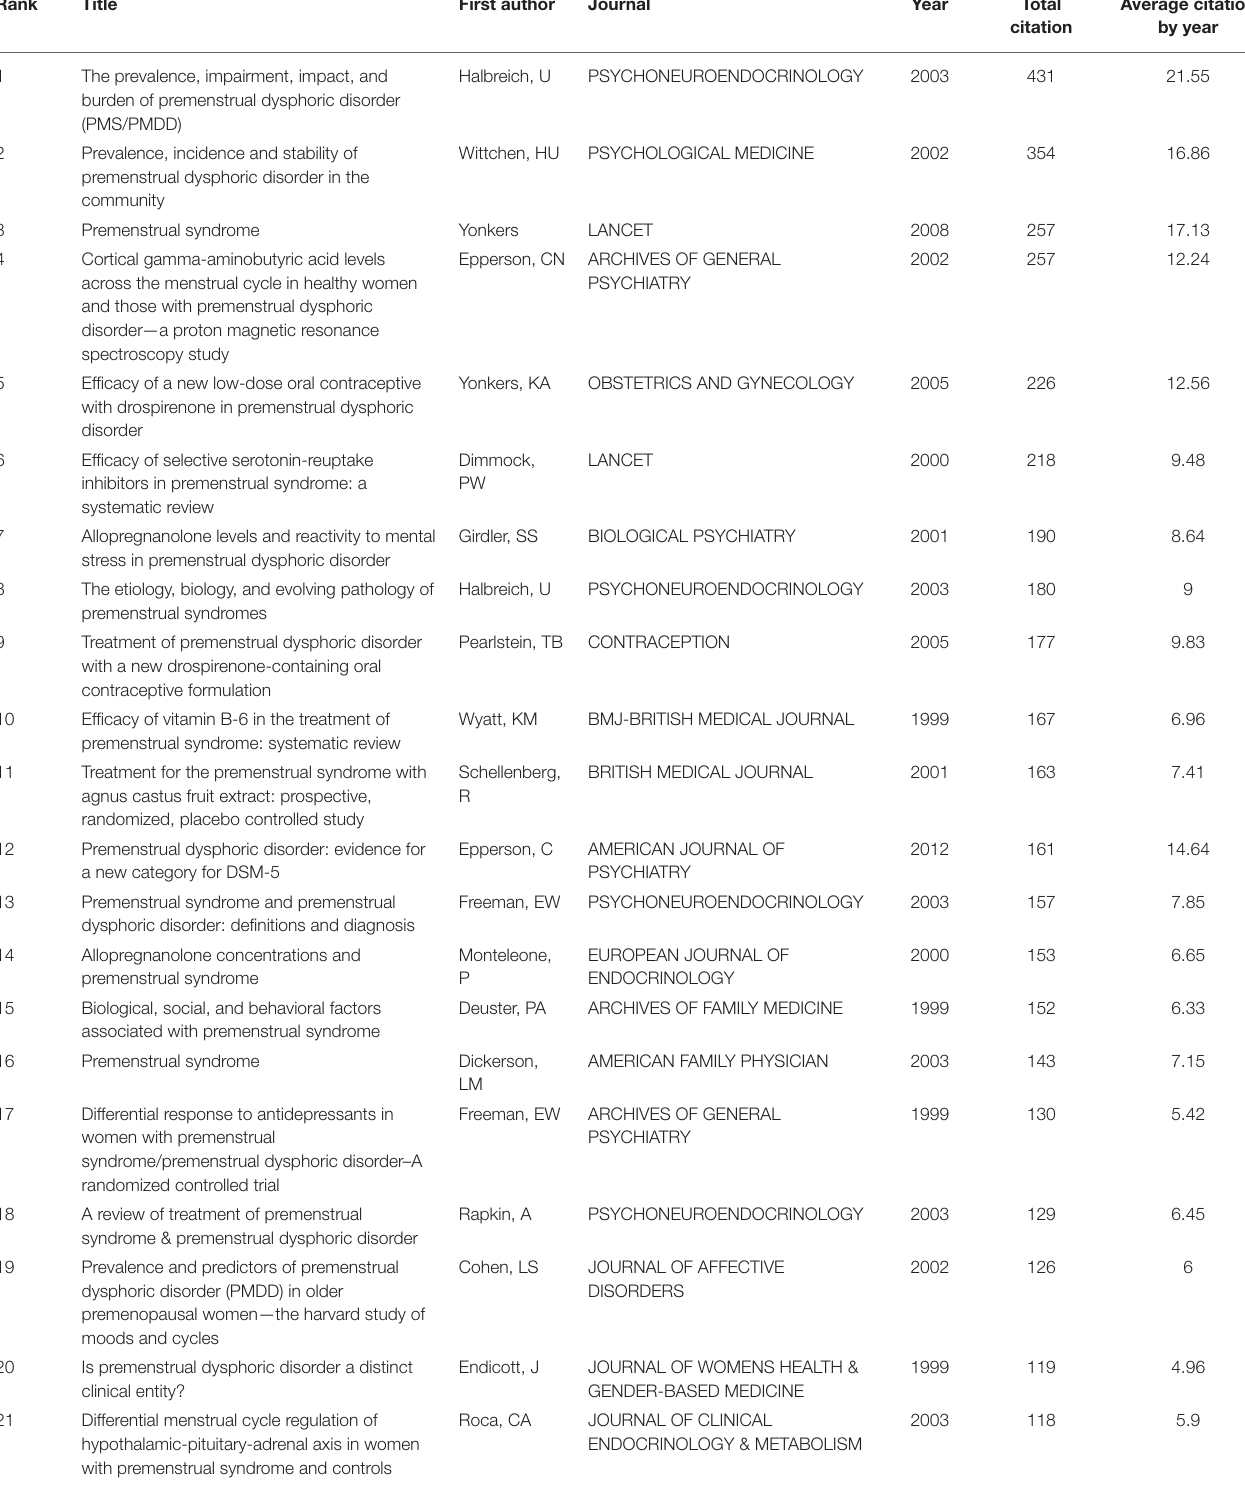
TABLE 1 | The 100 most cited papers in PMS/PMDD until